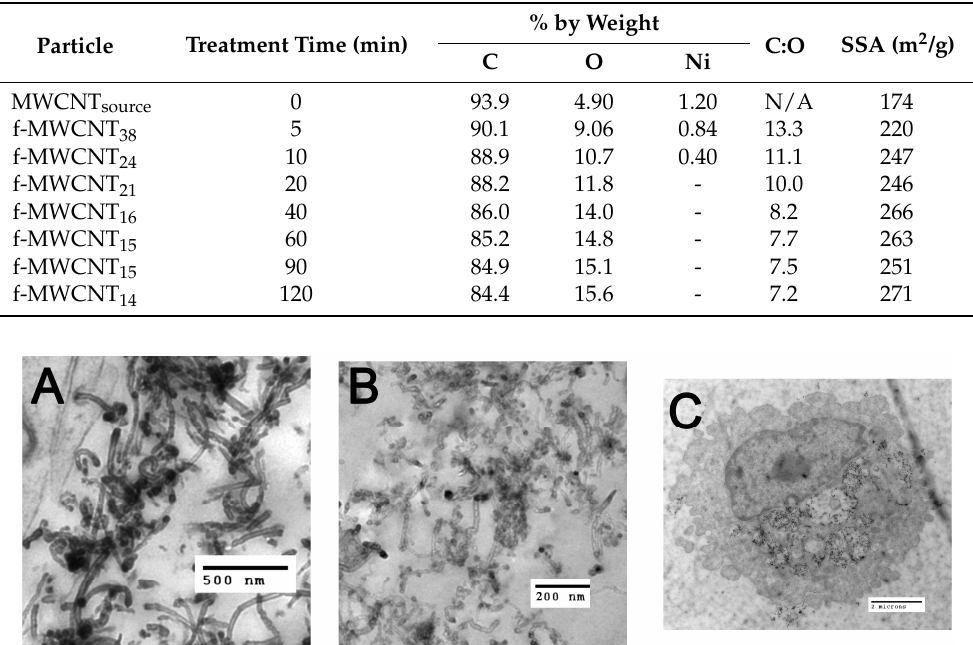
Table 2. Elemental analysis, C:O ratio, SSA of MWCNT and f-MWCNT. Particle